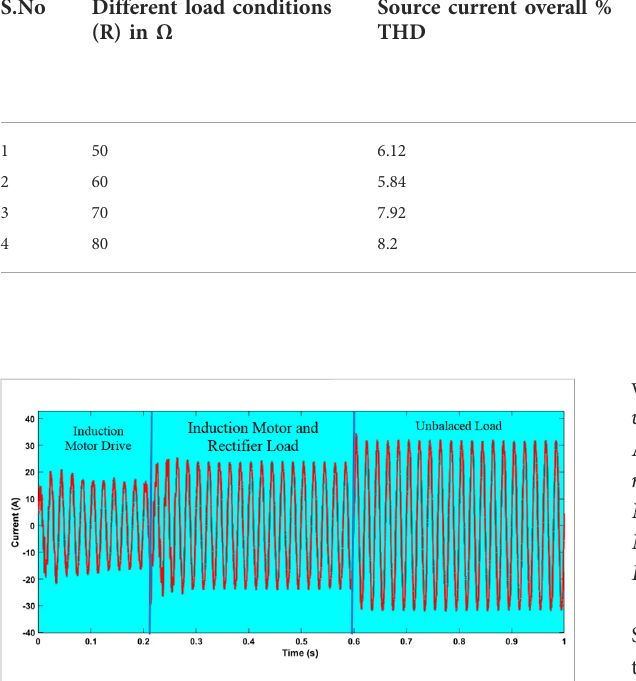
FIGURE 13 Source current for varying